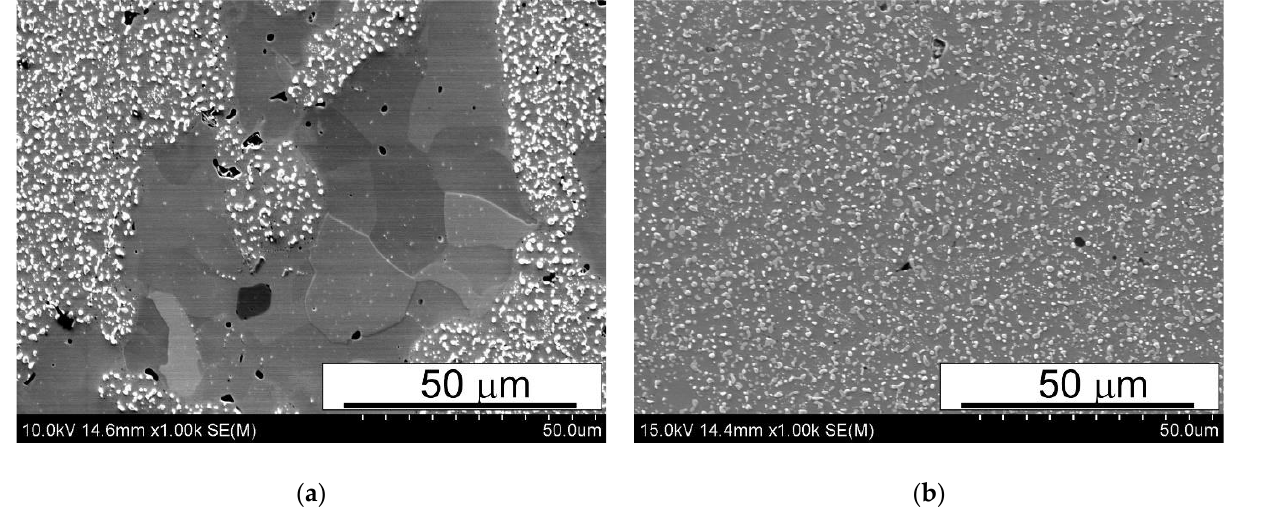
Figure 8. Microstructures of ( a ) T15+50%Fe and ( b ) T15 materials spark plasma sintered at 1050 °C; SEM.